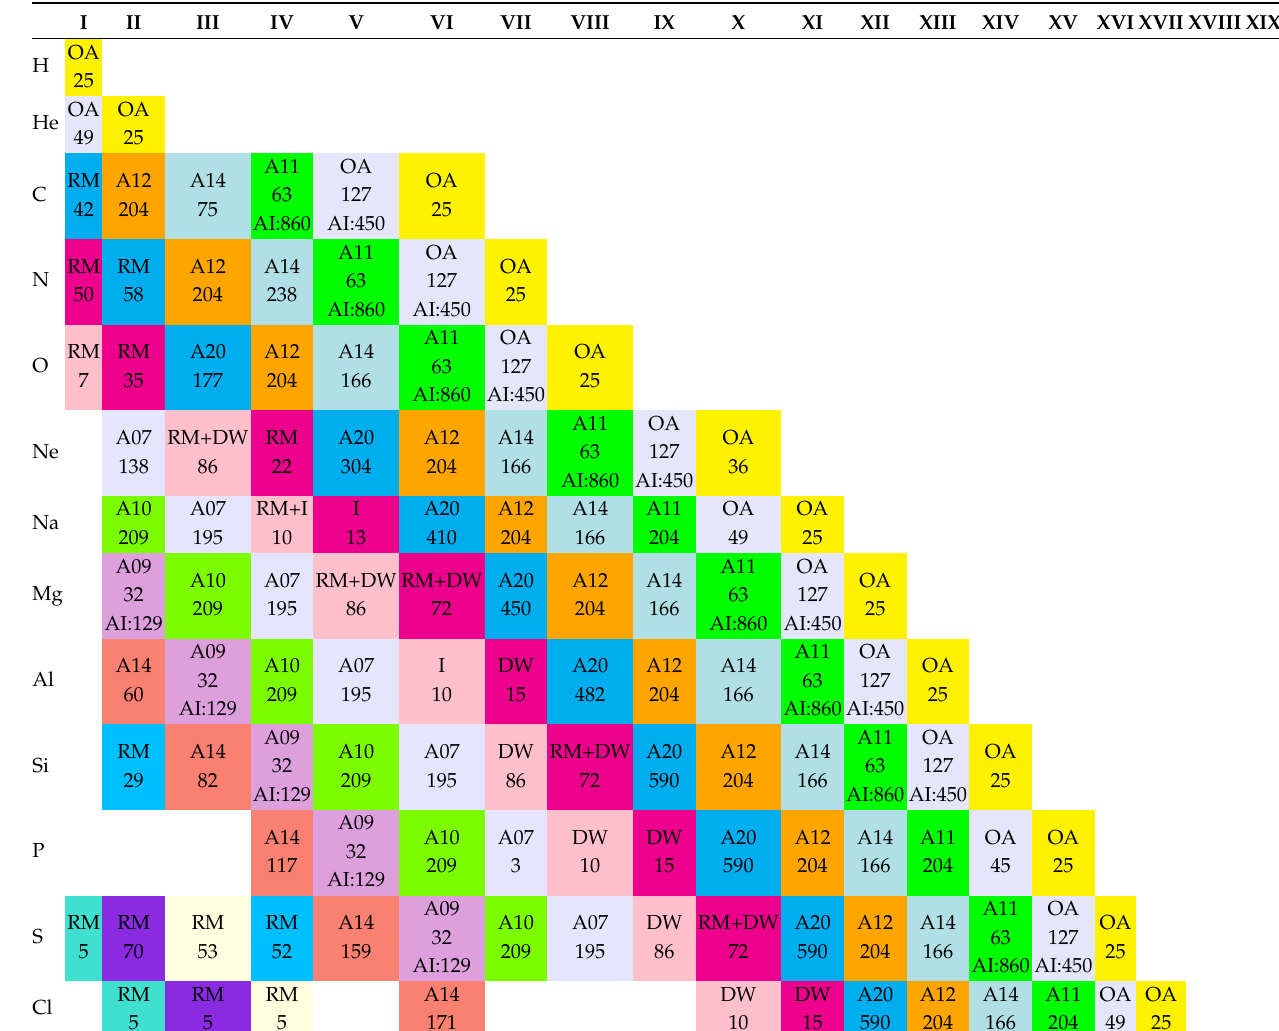
Table 1. Neutrals and ions currently present in the CHIANTI